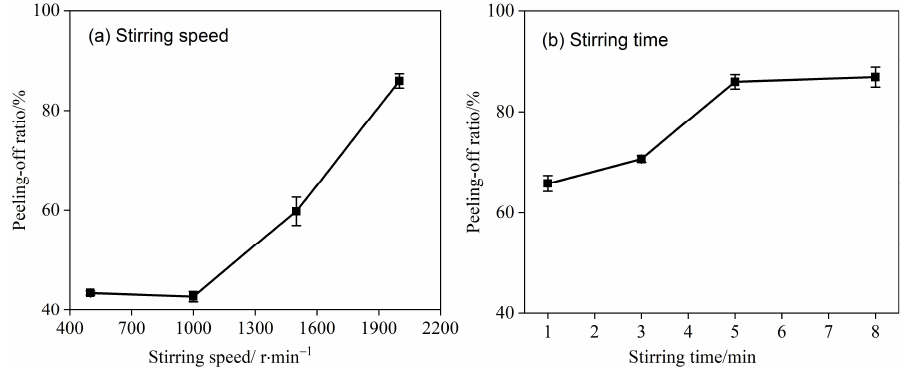
Figure 4. Effects of mechanical stirring speed (( a ) 5-min stirring time), and stirring time (( b ) 2000 r/min) on peeling-off ratios of the